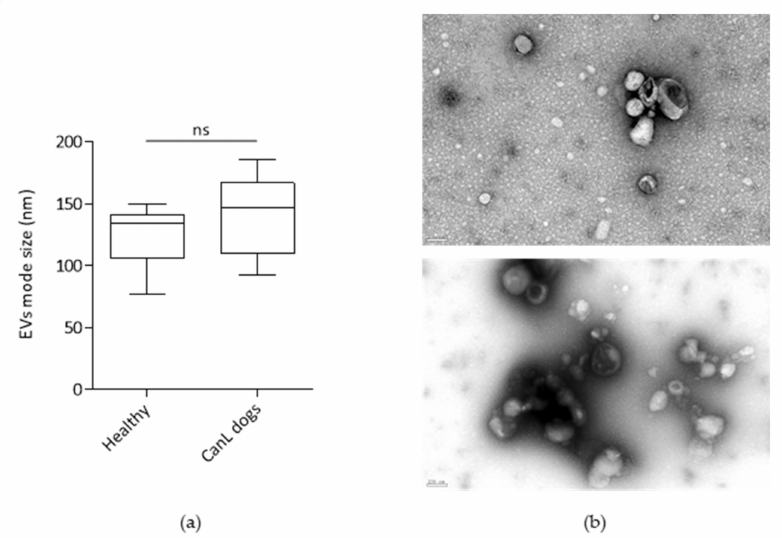
Figure 1. ( a ) Characterization of EVs mode size by NTA of the Healthy group (n = 8) and CanL group (n = 12). Statistical significance was determined using Mann–Whitney test. ns—non-significant; ( b ) representative images of plasma-derived EVs recovered by SEC from a CanL dog ( upper image) and healthy dog ( lower image) obtained with negative staining transmission electron microscopy, using Jeol JEM 1400 with STEM detector and EDS system. The bar in the lower left corner of the images represents 100